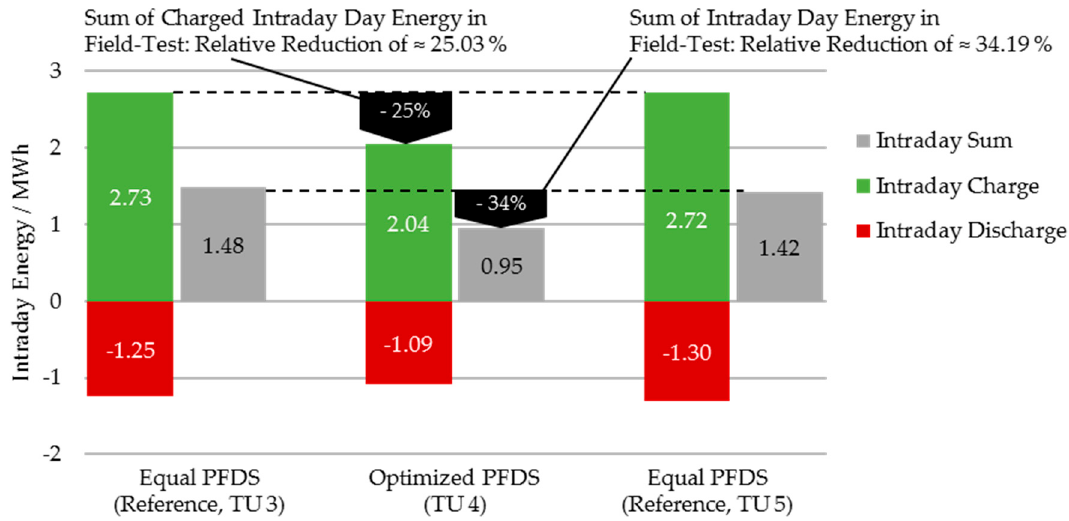
Figure 10. Field-test results for intraday energy charge/discharge/sum of TUs 3–5 for 3–14 August 2017. TU 3 and TU 5 operate on equal Power Flow Distribution Strategy (PFDS); TU 4 operates on optimized PFDS.